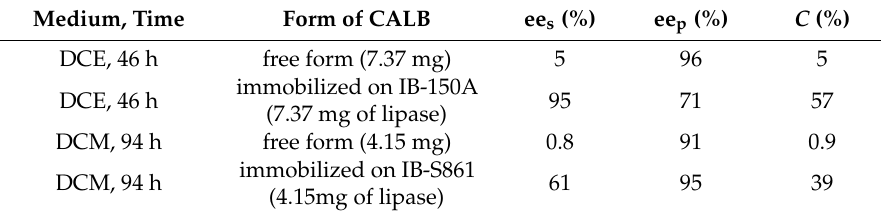
Table 3. The Comparison of catalytic activity of immobilized and free form of CALB. Medium, Time Form of CALB DCE, 46 h